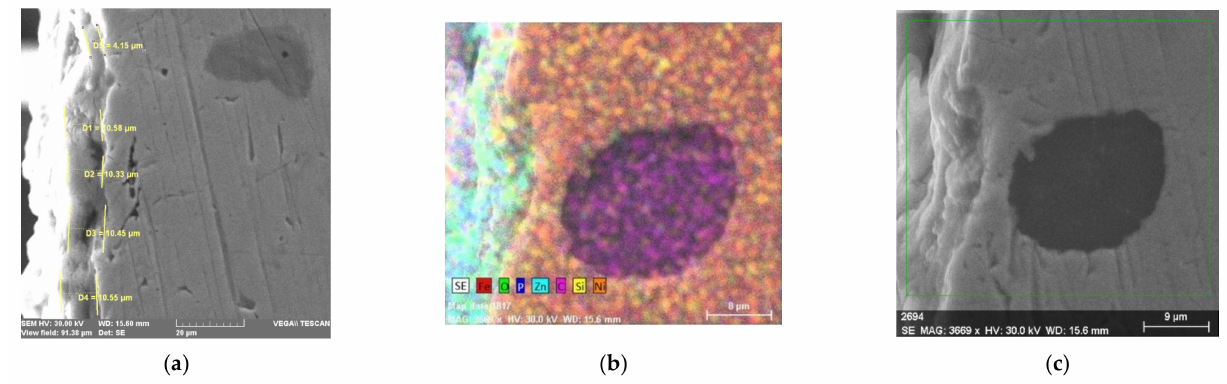
Figure 4. Cross section through the phosphate layer (1000 × ): ( a ) section showing the thickness of the layer, ( b ) section showing the mapping of the elements, ( c ) section showing the deposition near the graphite nodules (1500 ×